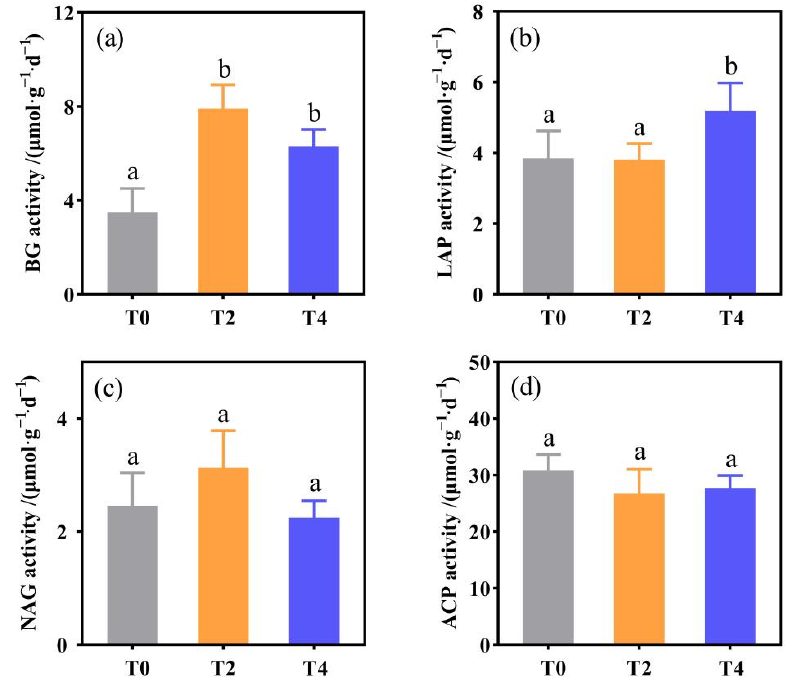
Figure 1. Changes in soil enzyme activities under different treatments: ( a ) the activity of BG ( β -1,4- glucosidase); ( b ) the activity of NAG ( β -1,4- N -acetylglucosidase); ( c ) the activity of LAP (L-leucine aminopeptidase); ( d ) the activity of ACP (acid phosphatase). T0: control without warming; T2: 2 ◦ C warming treatment; T4: 4 ◦ C warming treatment. Lowercase letters represent significant differences in soil enzyme activity under different treatments ( p < 0.05).